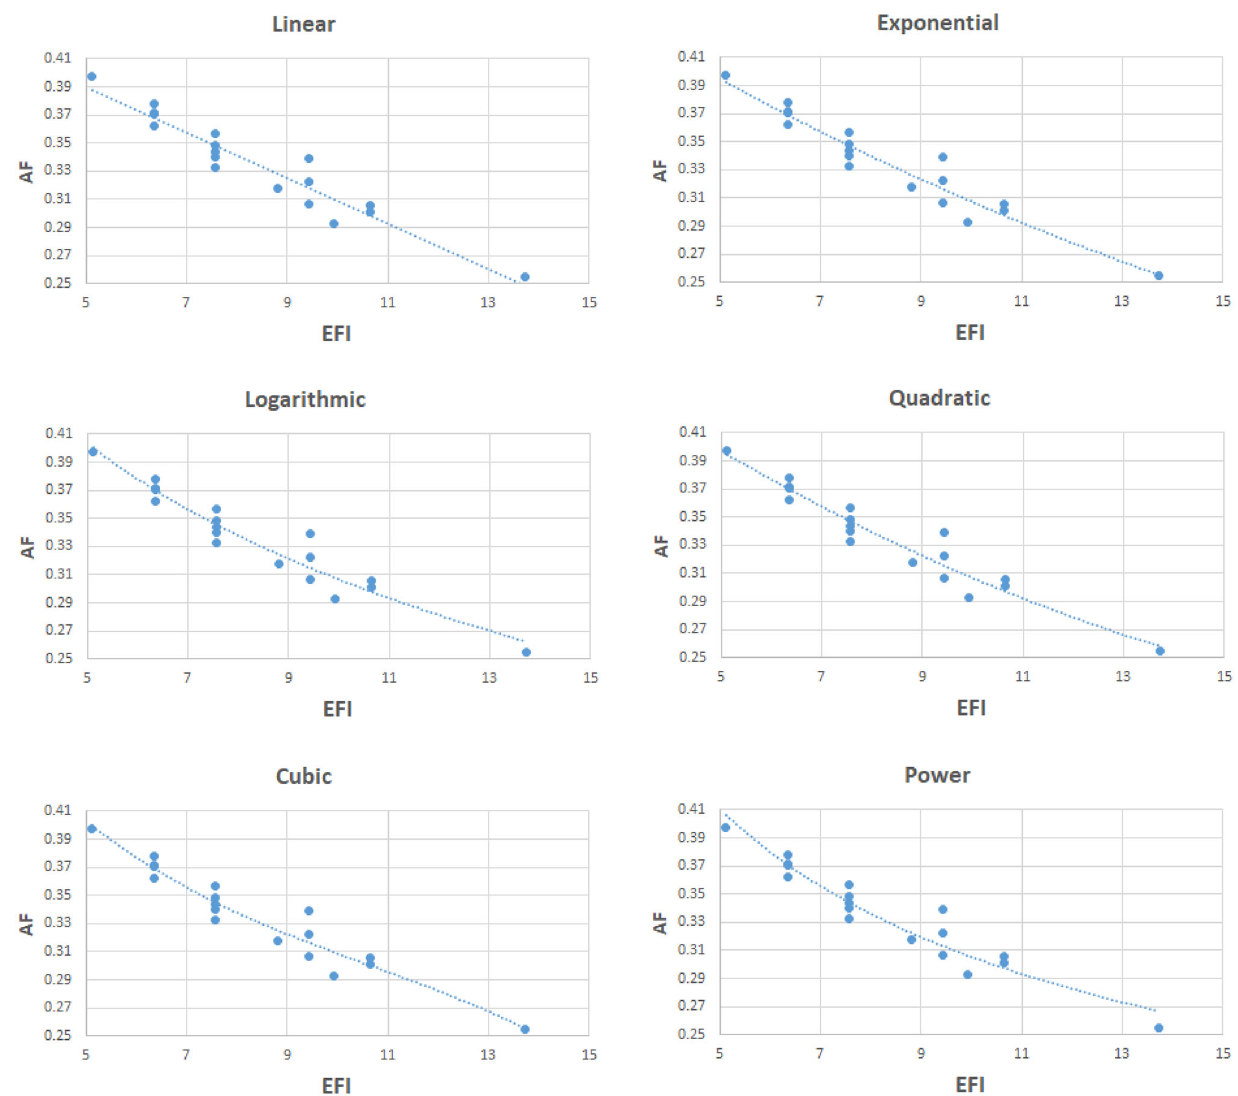
Fig. 6 The correlation of edge F-index with acentric factor for octane isomers